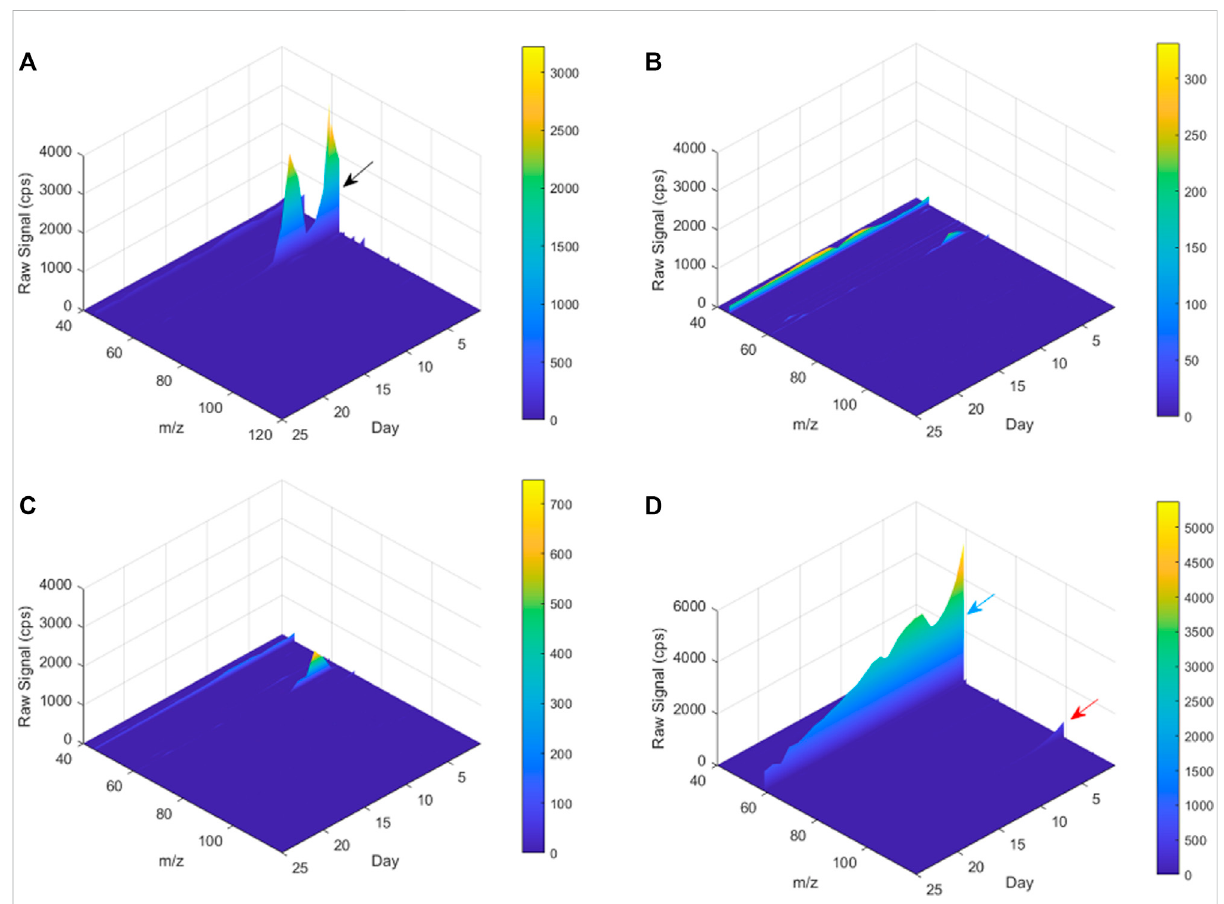
FIGURE 8 A 3D plot of PTR-TOF-MS spectra for m/z 40 – 120 from Day 1 to Day 25. (A) poly-(disulfanyl-n-decane) and soil mixture, (B) reference material and soil mixture, (C) only soil (blank), (D) only poly-(disulfanyl-n-decane). The black, blue and red arrows mark the peaks of m/z 63, 59 and 99,